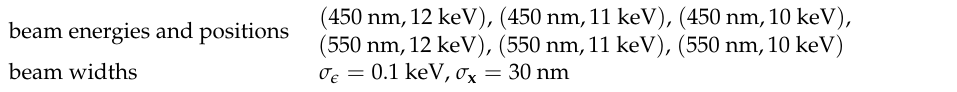
Table 2. Beam configurations used to generate synthetic k-ratio measurements. beam energies and